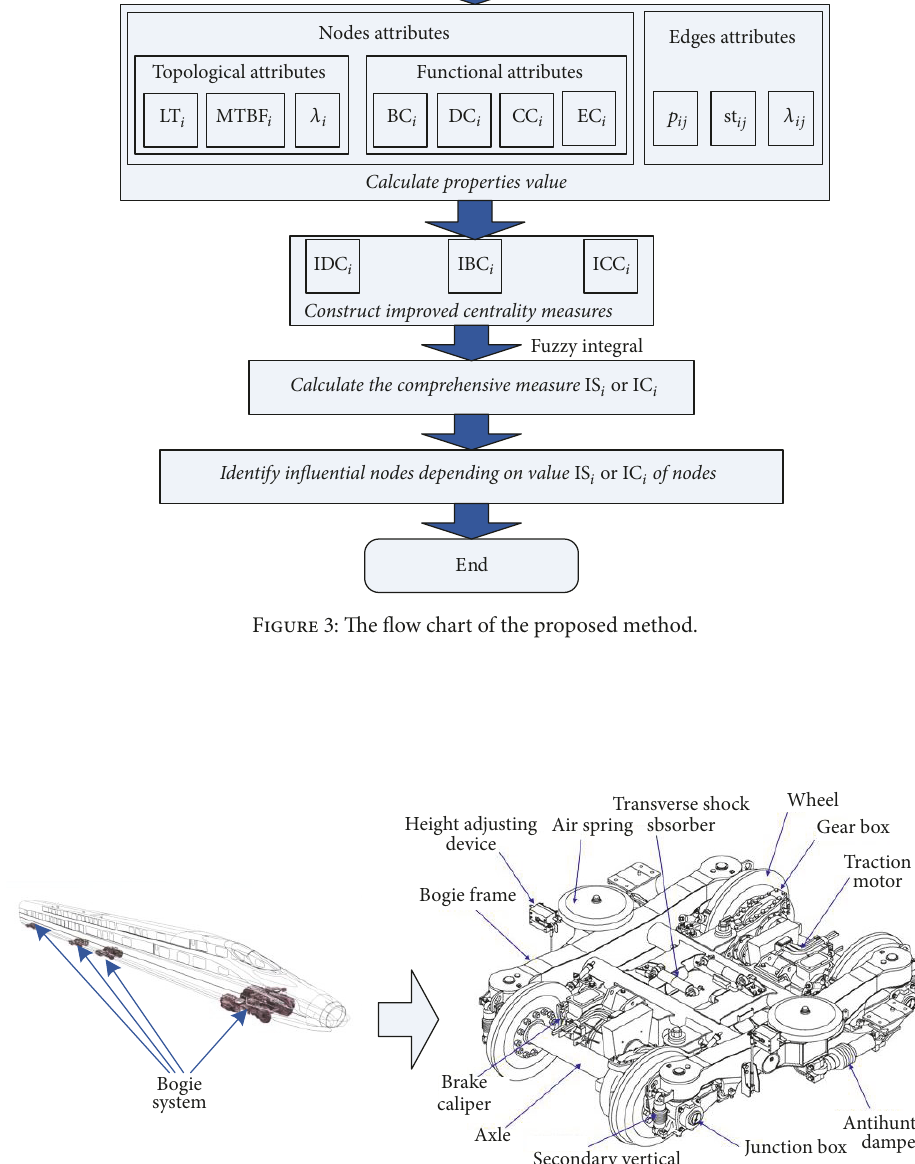
Figure 4: Structural features of bogie